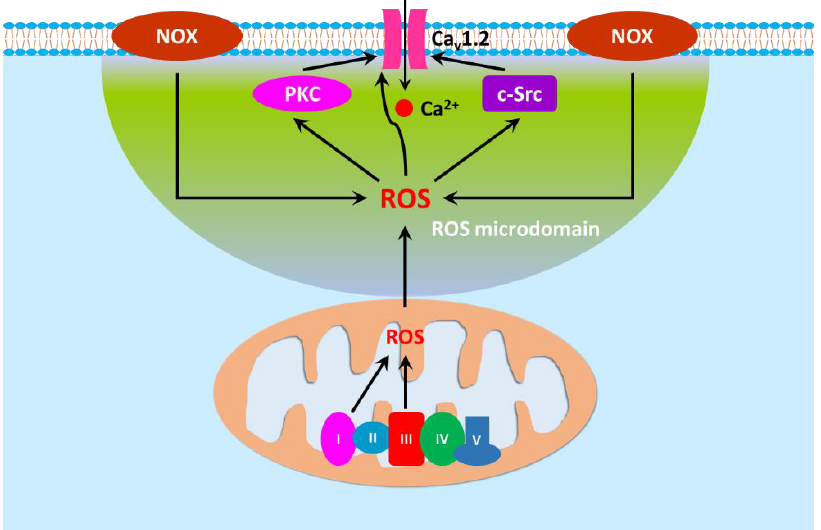
Figure 4. Regulation of Ca v 1.2 by ROS microdomains. In vascular smooth muscle cells, ROS-derived from NOXs in plasma membrane and/or subcellular mitochondria in the immediate vicinity of Ca v 1.2 channels form ROS microdomains. Ca v 1.2 activity can be altered directly and indirectly by ROS. Within ROS microdomains, ROS can directly target cysteine residues in Ca v 1.2 to modify channel activity. In addition, ROS can also trigger ROS-dependent activation of PKC and/or c-Src. Activated PKC and c-Src in turn phosphorylate Ca v 1.2 and enhance channel activity. Remarkably, ROS also regulate gene expression [460,461]. There is a concurring decrease in both vascular ROS and Ca v 1.2 expression in aortas of aged mice lacking the mineralocorticoid receptor in smooth muscle cells [142]. The protein expression of the α 1C subunit is increased by angiotensin II in cultured rat mesenteric arteries [462,463]. H 2 O 2 mimics, while NOX inhibition by apocynin, diphenyleneiodonium and gp91ds-tat as well